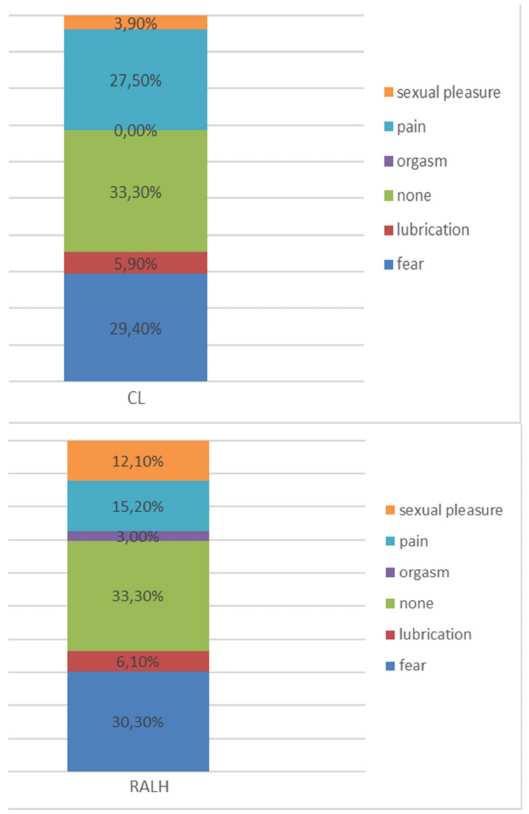
Figure 4. Limitation of sexual intercourse after the operation. Fear and pain were the most frequent